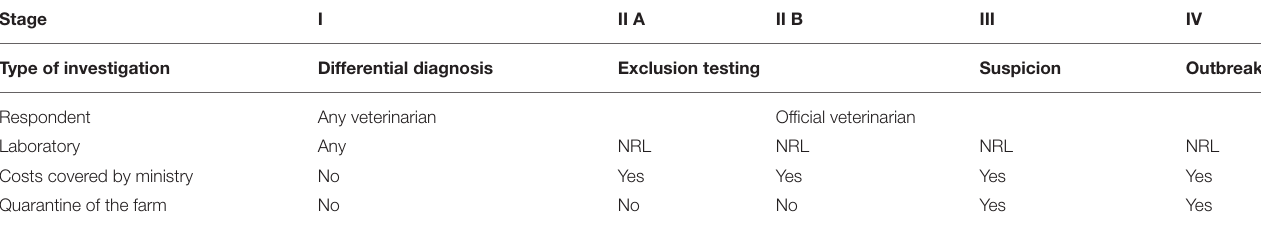
TABLE 2 | Stages of the Austrian FMD testing